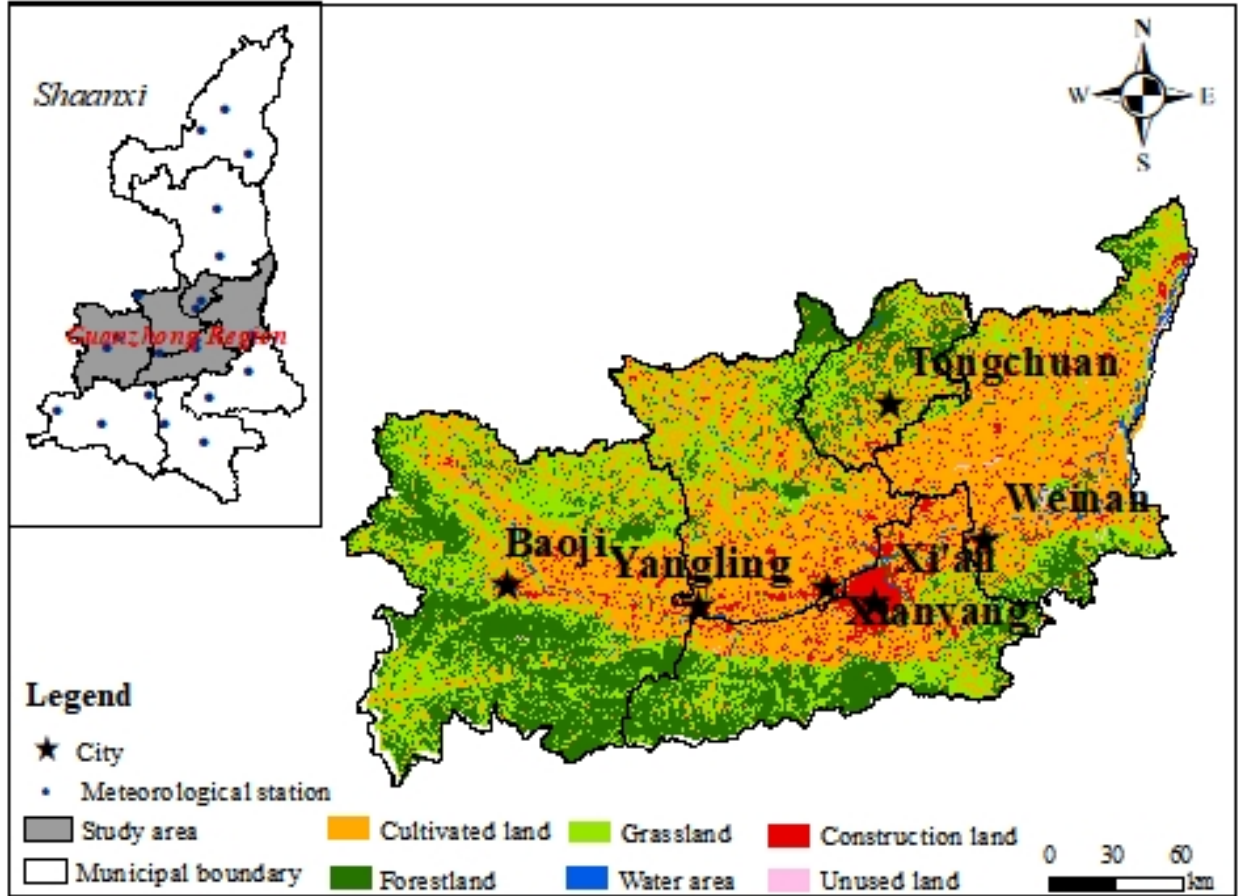
Figure 1. Geographical location and land over types of study areas in 2018.